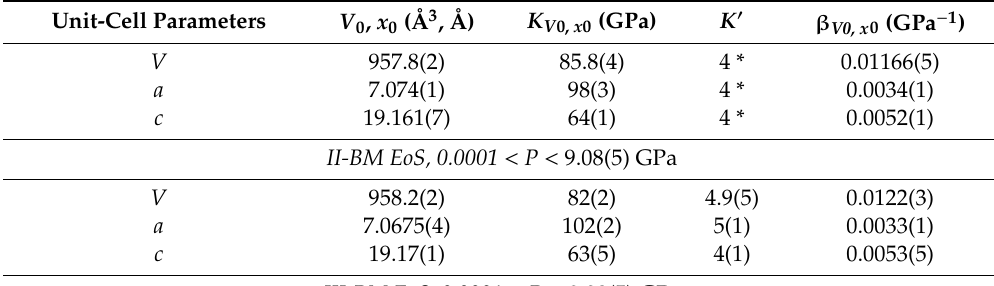
Table 2. Refined elastic parameters of wardite, based on the isothermal II- and III-Birch–Murnaghan (BM) Equation of State fits (* fixed